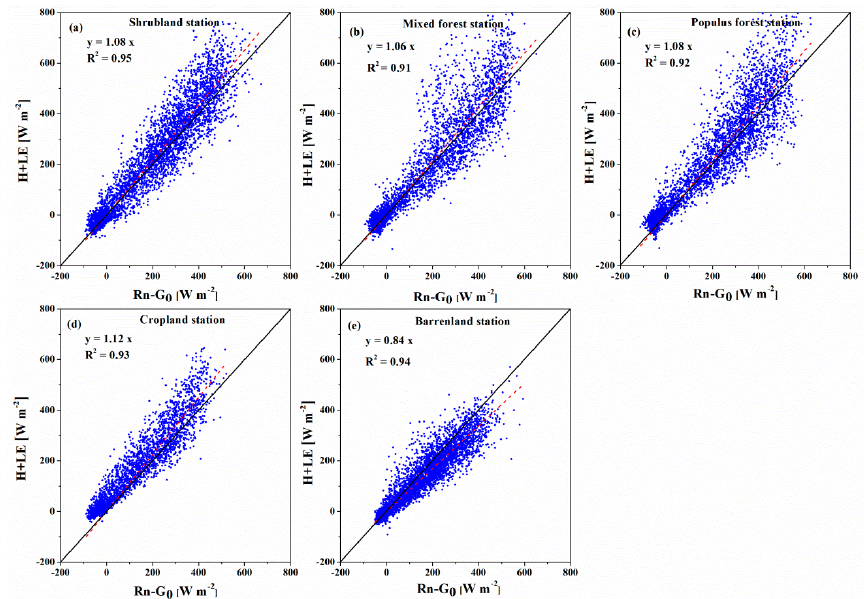
Figure 5. Relationships (including equations and R 2 ) between the available energy (x axis) and the sum of turbulent energy fluxes (y axis) based on the 30 min EC data (May–October 2014) at the ( a ) Shrubland station, ( b ) Mixed forest station, ( c ) Populus forest station, ( d ) Cropland station, ( e ) Barrenland station, respectively. The black line is the 1:1 line, and the red dash line is the linear fit line determined using the OLSs.